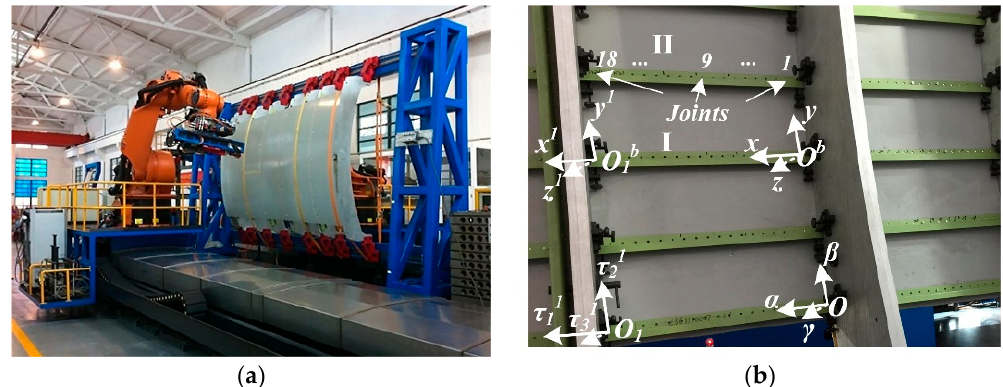
Figure 3. Experiment platform of aircraft fuselage panel assembly. ( a ) Aircraft assembly platform; ( b ) substructure of fuselage panel.